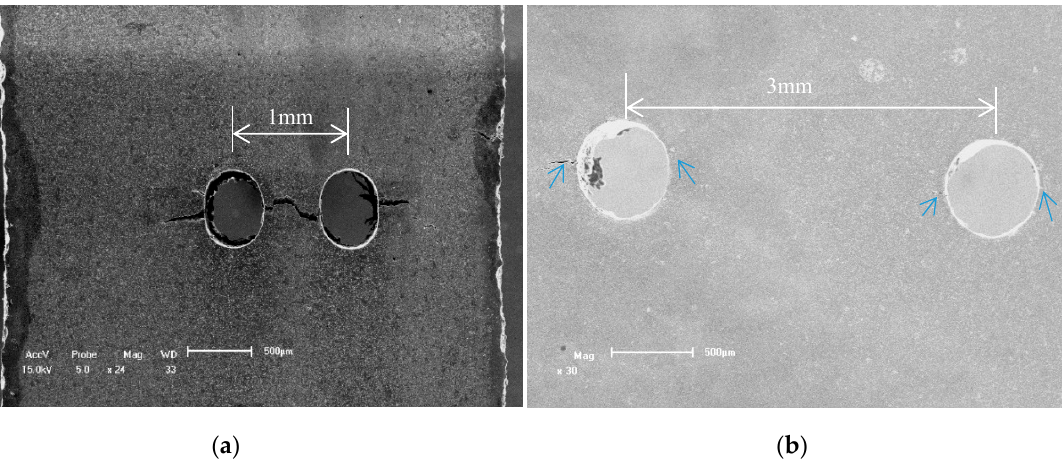
Figure 5. Fatigue crack initiation and propagation behavior of cast AM60B alloy with tilted 90° and different hole distances of two small holes. ( a ) N = 9446 ( N f = 17,433), σ max = 120 MPa, 2D, R = 0.1. ( b ) N = 25,046 ( N f = 25,202), σ max = 120 MPa, 6D, R = 0.1